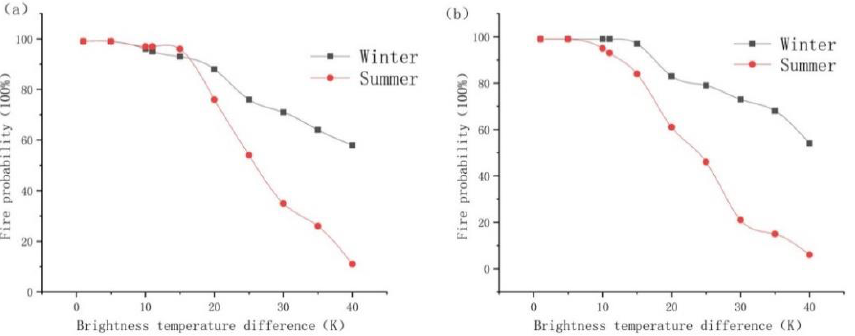
Figure 4. Comparison of brightness temperature thresholds of channels I4 ( a ) and I4-I5 ( b ). The y -axis shows the difference in the brightness temperature between the fire pixels in the centers of each channel and the adjacent effective pixel in the window, and the x -axis shows the fire probability.